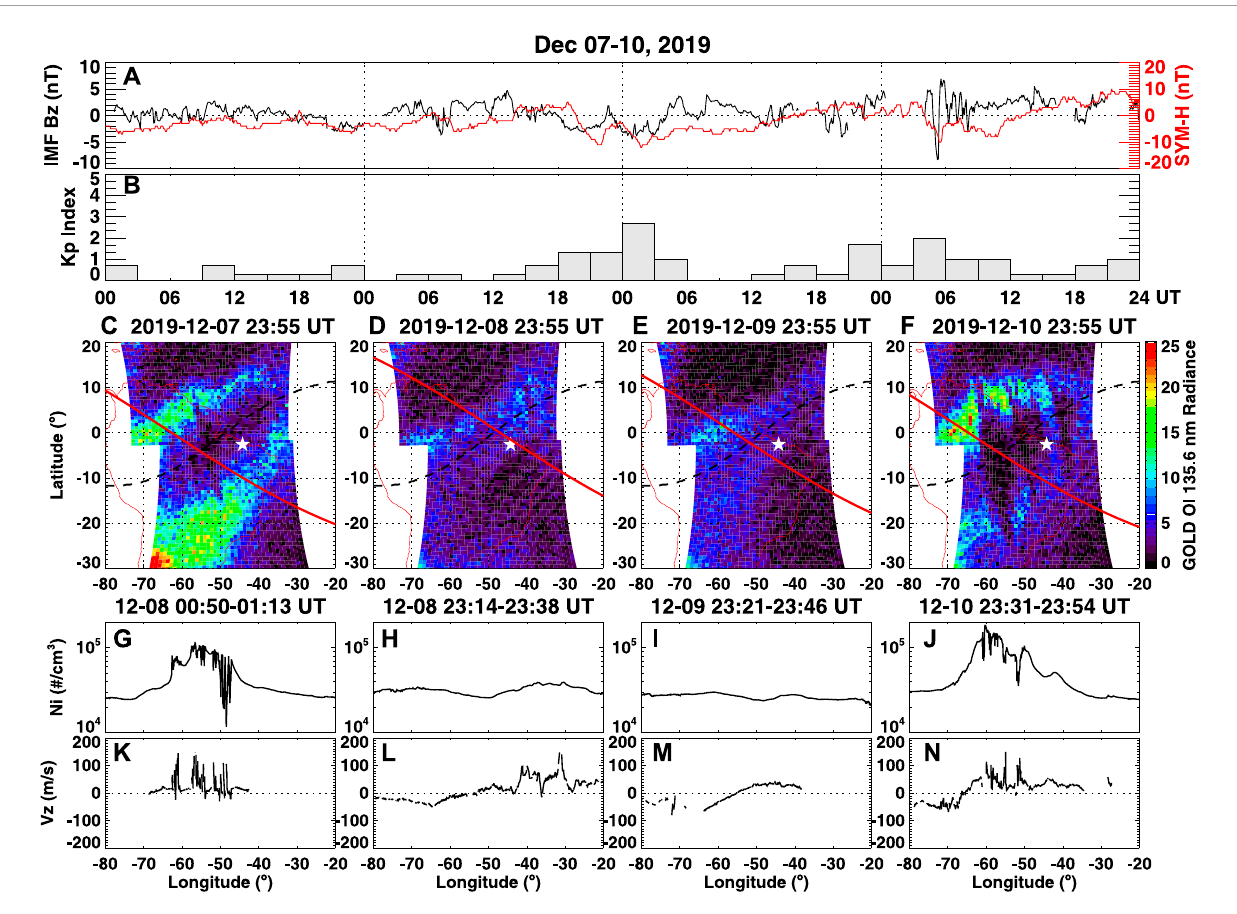
FIGURE 1 (A,B) Interplanetary magnetic field (IMF) Bz, longitudinally symmetric index (SYM-H), and Kp index variations during December 07–10, 2019. (C–F) GOLD nighttime ultraviolet images of OI 135.6 nm emission radiance at 23:55 UT on December 07–10, respectively. The Sao Luis ionosonde (white star), overlapping ICON orbit (red line), and the geomagnetic equator (black dashed line) are also marked. (G–N) Corresponding longitudinal profiles of ICON IVM plasma density and vertical